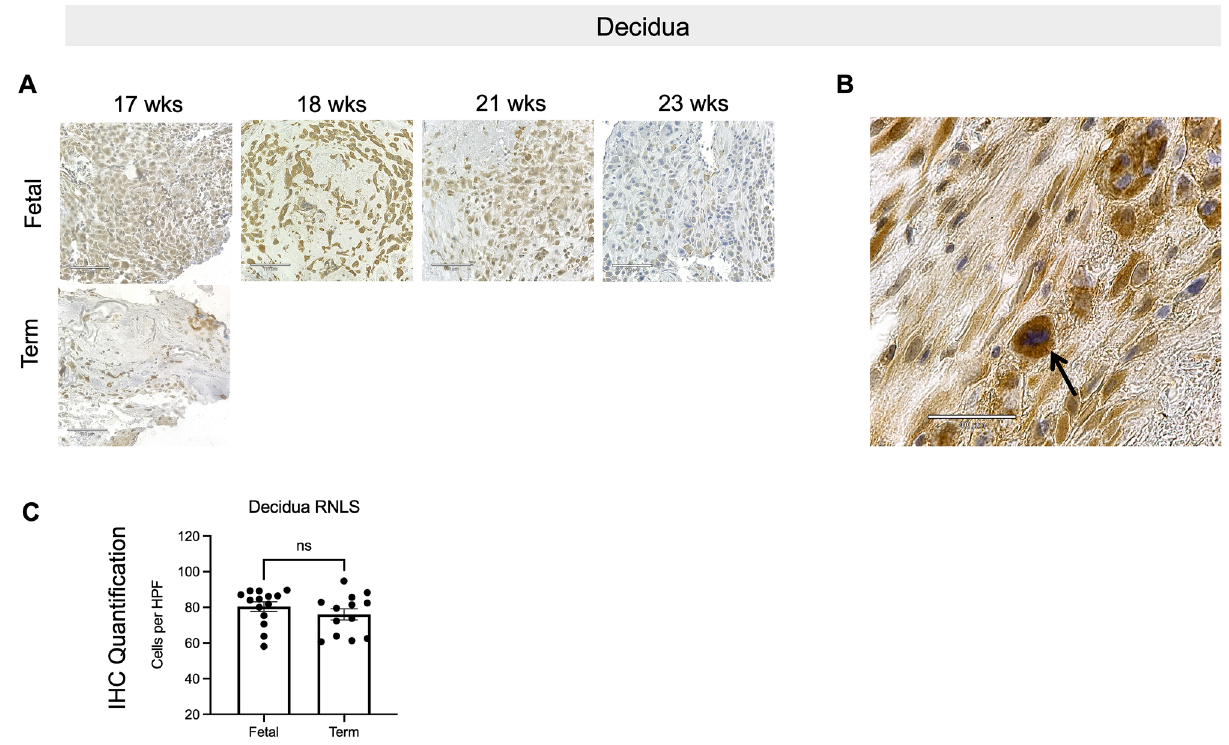
Figure 2. RNLS is detected in the decidua. (A) RNLS staining in decidua throughout development during fetal and term-time points. (B) Representative decidua with an arrow pointing to region of RNLS staining in a cell within the decidua. Immunohistochemistry with hematoxylin staining for RNLS using m28-RNLS antibody at 20x (A) and 60x (C) . (C) Quantification of RNLS staining during fetal and term-time points in the decidua (n = 4). HPF-high-power field. Post hoc analysis completed after two-tailed Mann–Whitney test. All graphs use the mean for average values and standard error for error bars. Black arrow pointing at RNLS positive